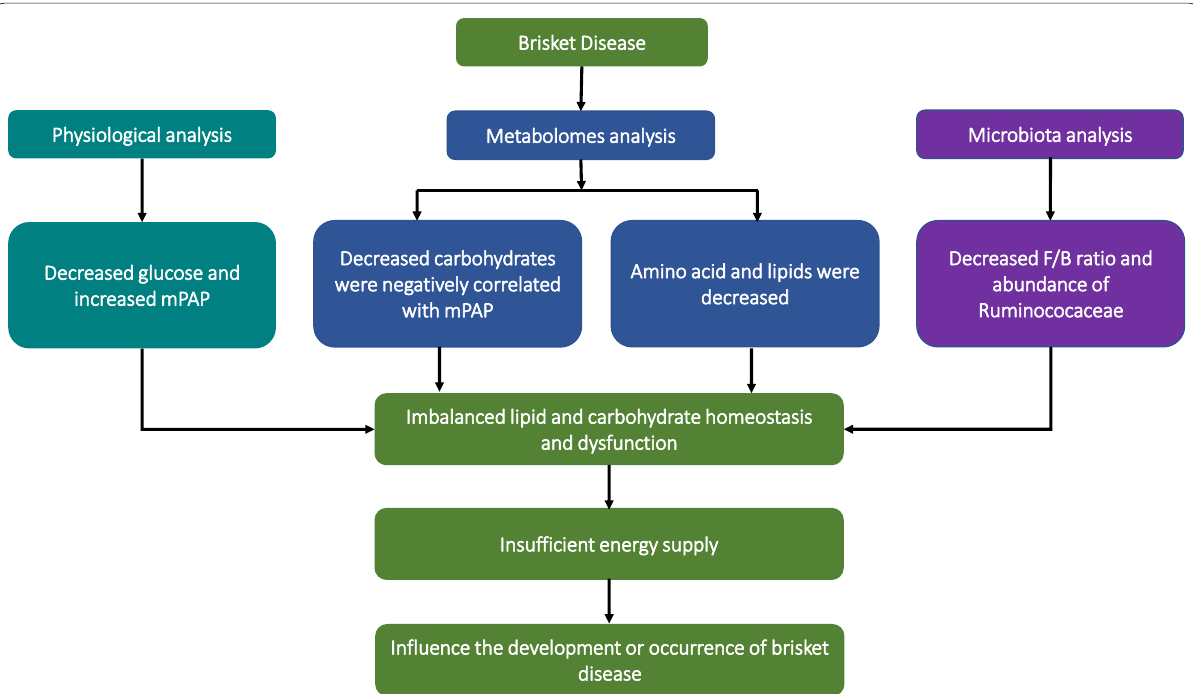
Fig. 4 The hypothesis mechanism of occurrence or development of BD. MPAP mean pulmonary artery pressure, F/B